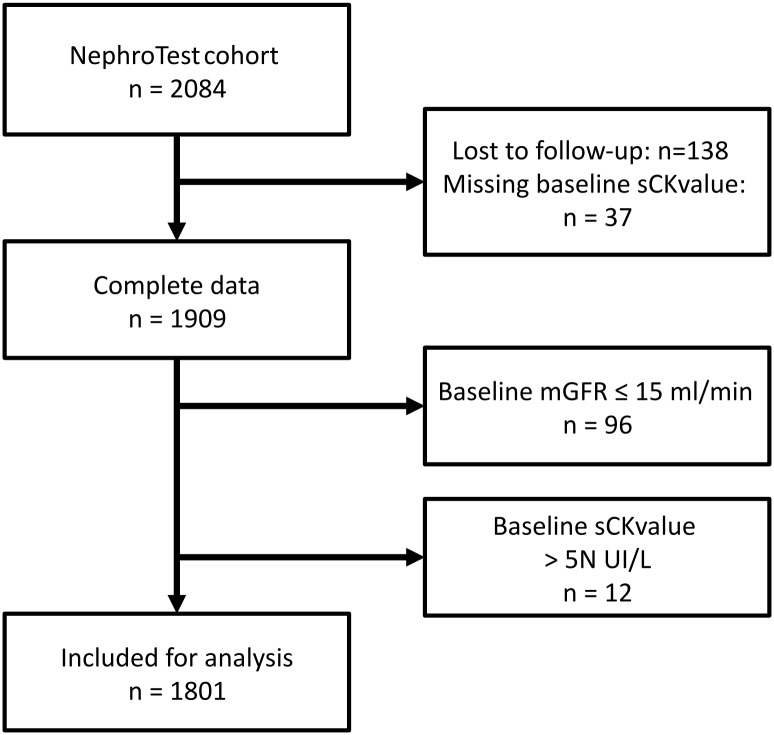
Study flowchart.